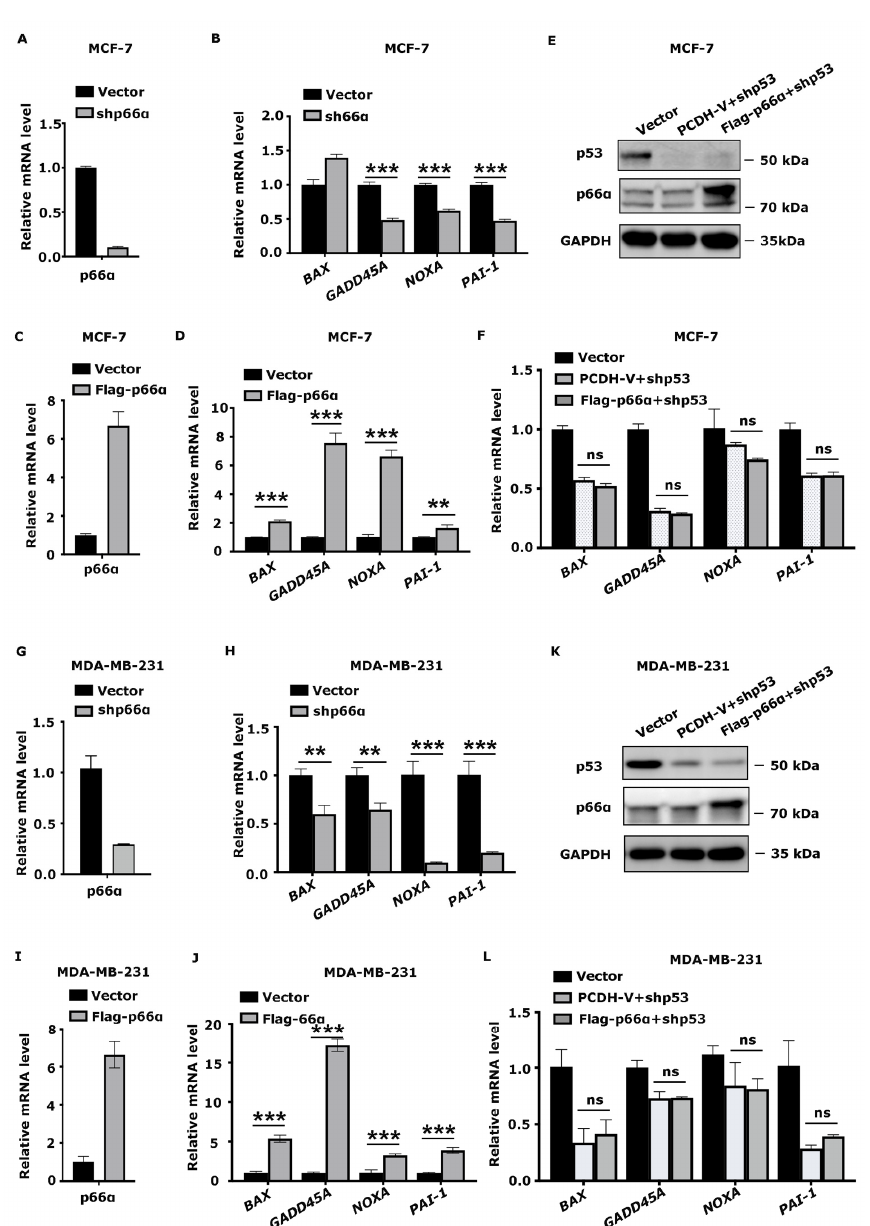
Figure 4. p66 α promotes the expression of transactivated p53 target genes via p53. ( A ) qRT-PCR assays verified the mRNA level of p66 α in MCF-7 shVector and shp66 α cells. ( B ) The repression of p66 α decreased the mRNA level of p53 target genes in MCF-7 cells. *** p < 0.001. ( C ) qRT-PCR assays verified the mRNA level of p66 α in Flag-p66 α overexpressing MCF-7 cells. ( D ) Overexpression of p66 α increased the mRNA levels of p53 downstream genes in MCF-7 cells. ** p < 0.01, *** p < 0.001. ( E ) Western blot assays verified the protein levels of p53, p66 α in p66 α overexpressing MCF-7 cells after the depression of p53. ( F ) qRT-PCR assays of the mRNA level of p53 downstream genes after the depression of p53 in p66 α overexpressing MCF-7 cells. “ns” indicates no significant difference ( p > 0.05). ( G ) qRT-PCR assays verified the mRNA level of p66 α in MDA-MB-231 shVector and shp66 α cells. ( H ) Repression of p66 α decreased the mRNA level of p53 downstream genes in MDA-MB-231 cells. ** p < 0.01, *** p < 0.001. ( I ) qRT-PCR assays verified the mRNA level of p66 α in MDA-MB-231 Flag-p66 α overexpressing cells. ( J ) Overexpressing p66 α induced the mRNA level of p53 downstream genes. *** p < 0.001. ( K ) Western blot assays verified the protein levels of p53, p66 α in p66 α overexpressing MDA-MB-231cells after the depression of p53. ( L ) qRT-PCR assays of the mRNA level of p53 downstream genes after the depression of p53 in p66 α overexpressing MDA-MB-231 cells. “ns” indicates no significant difference ( p > 0.05). All data were shown as mean ± S.D. from three independent